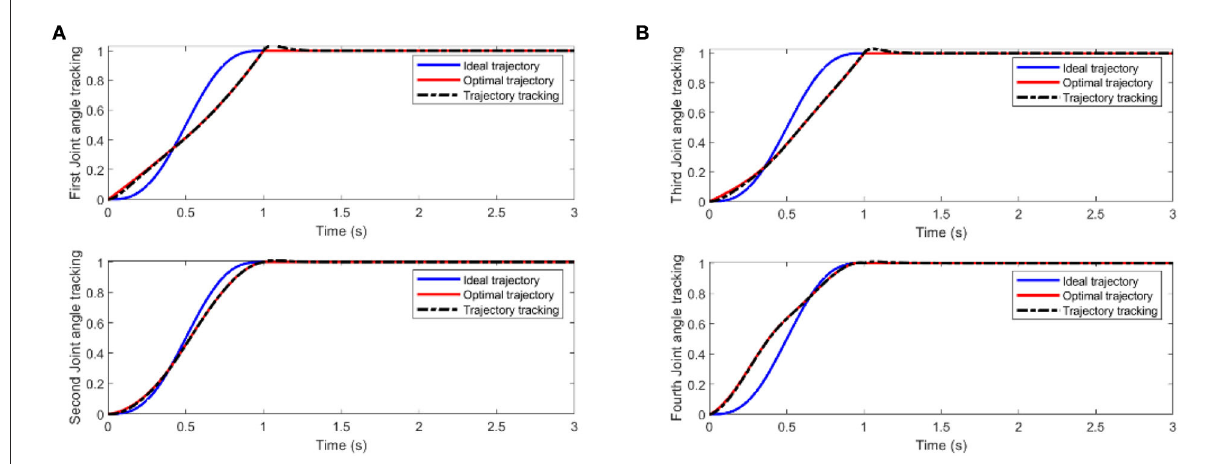
FIGURE12 (A) Two-joint angular tracking of end-effector. (B) Two-joint angular tracking of